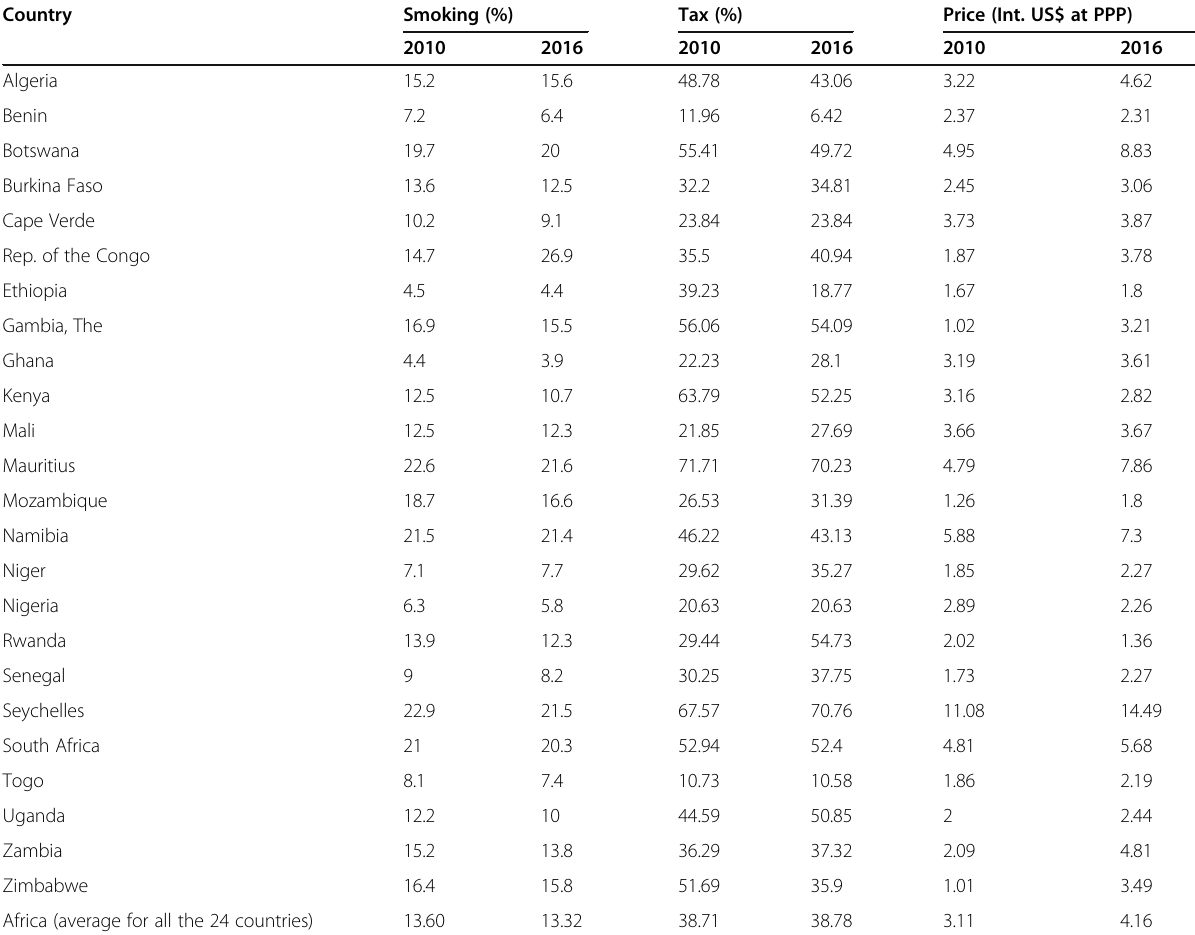
Table 2 Trend in smoking prevalence, tobacco taxation and pricing per country (2010 – 2016) Country